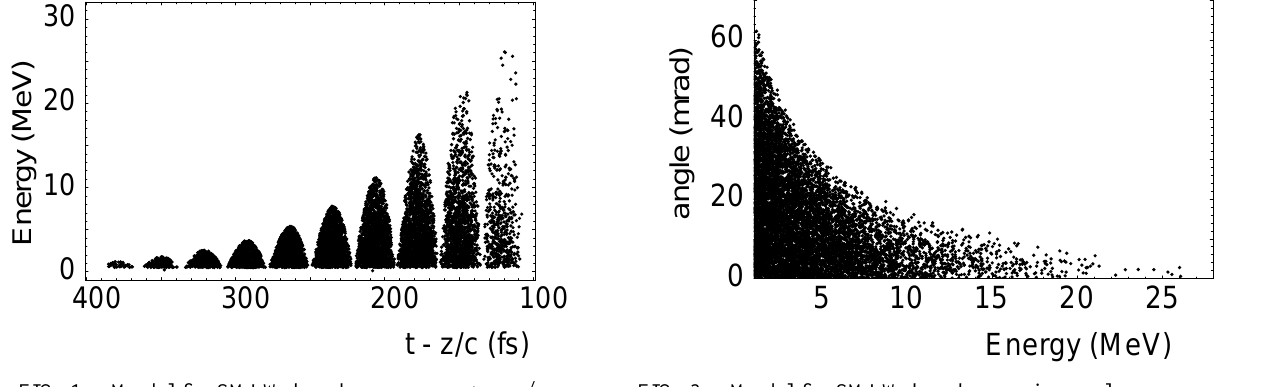
FIG. 1. Model for SMLW bunch: energy vs t 2 z (cid:3) c .